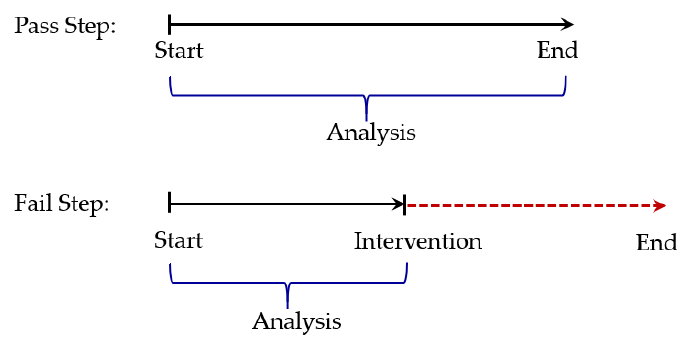
Figure 9. Data included in the analysis from each of the two groups.